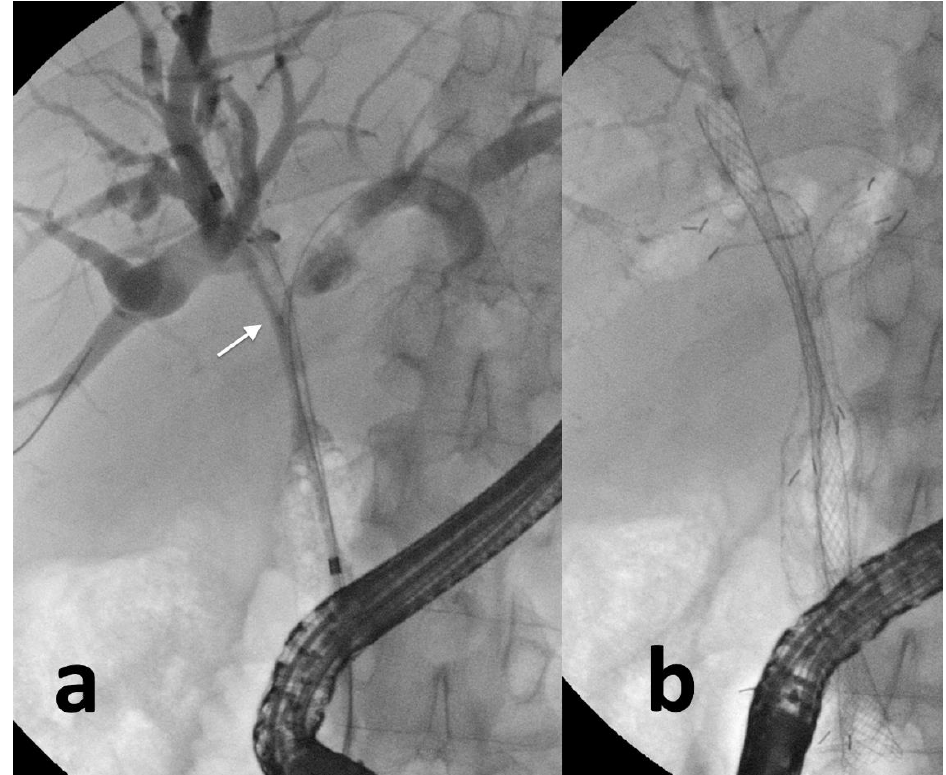
Figure 2. Complex hilar biliary stricture (arrow) in a patient with gallbladder cancer ( a ); three self-expandable metal stents are inserted ( b ) to obtain definitive palliation.